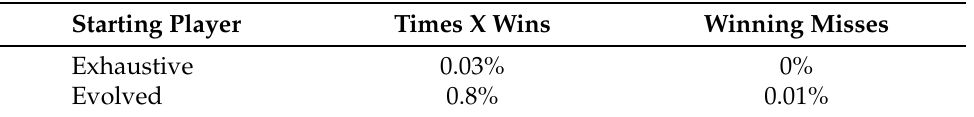
Table 4. Validation of top, evolved individual: Number of times X wins compared to all possible ways that X may win, and number of times O missed a possible win compared to the number of possible ways for O to